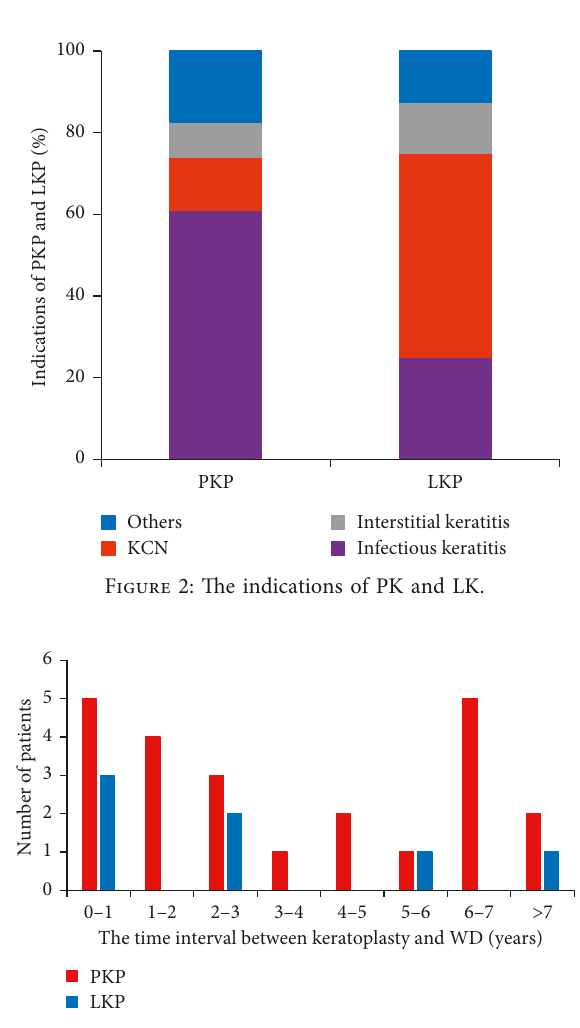
Figure 3: The time interval between keratoplasty and occurrence of